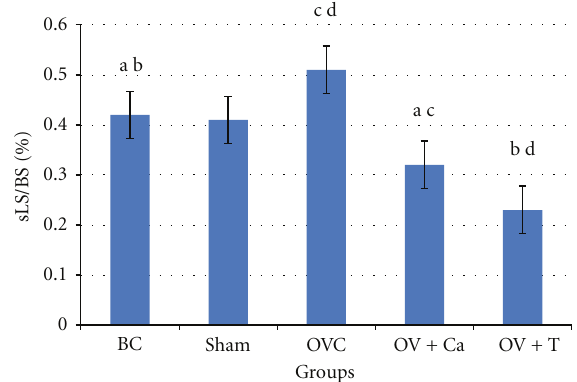
Figure 1: Single-labeled surface (sLS/BS). BC: baseline control group. Sham: sham-operated rats given deionised water and vehicle olive oil. OVC: ovariectomised rats given deionised water and vehicle olive oil. Ov+Ca: ovariectomised rats given 1% calcium in deionised water and vehicle olive oil. Ov+T: ovariectomised rats given deionised water and palm tocotrienol. Same alphabet indicates significant di ff erence between the groups ( P < 0 .